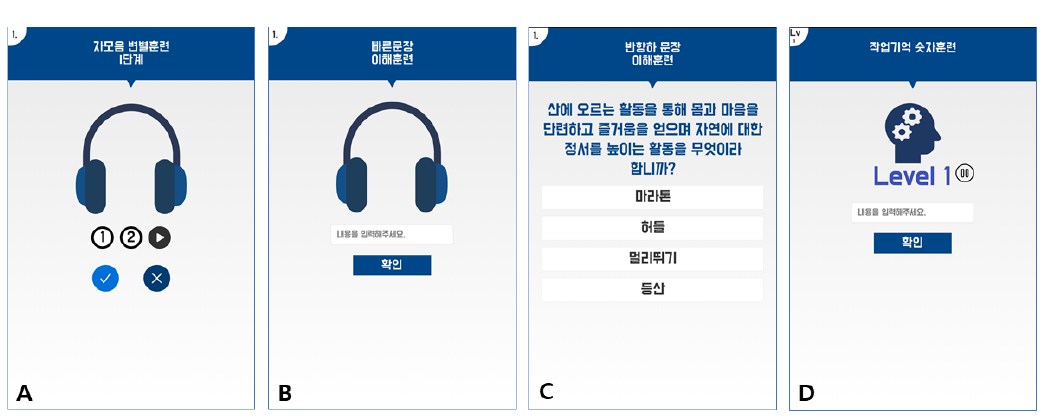
Table 1. Group mean scores and standard deviation for original items of technology acceptance model questionnaire.